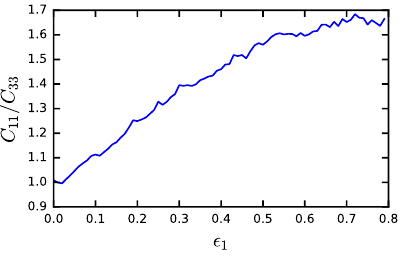
Figure 8. Ratio C 11 / C 33 of axial to transverse longitudinal elastic moduli, versus ✏ 1 in triaxial compression ( P ⇤ = 0 .